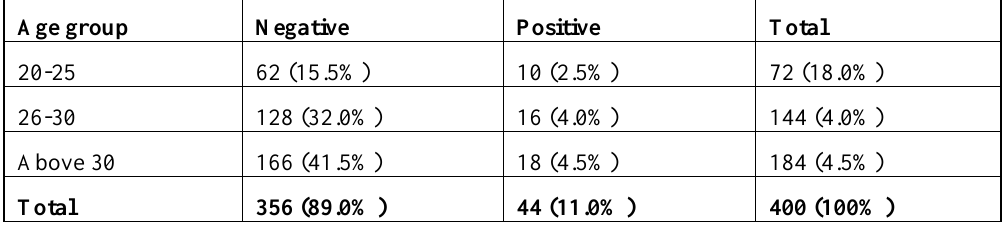
Table 3. Age distribution and hepatitis B status among pregnant women in Ilorin.